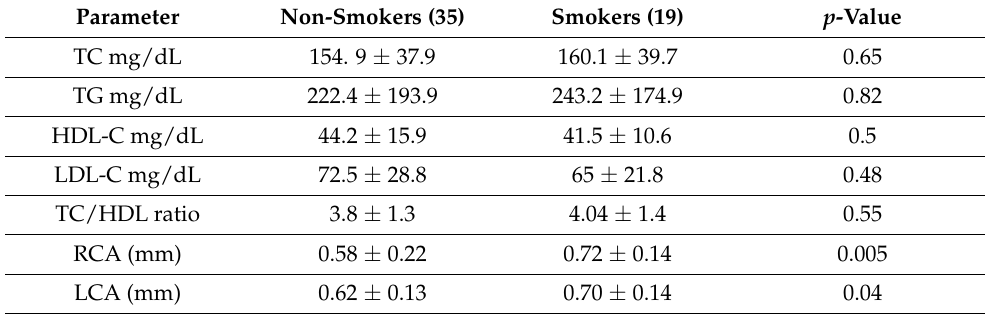
Table 2. Mean values of the investigated parameters in the study groups.